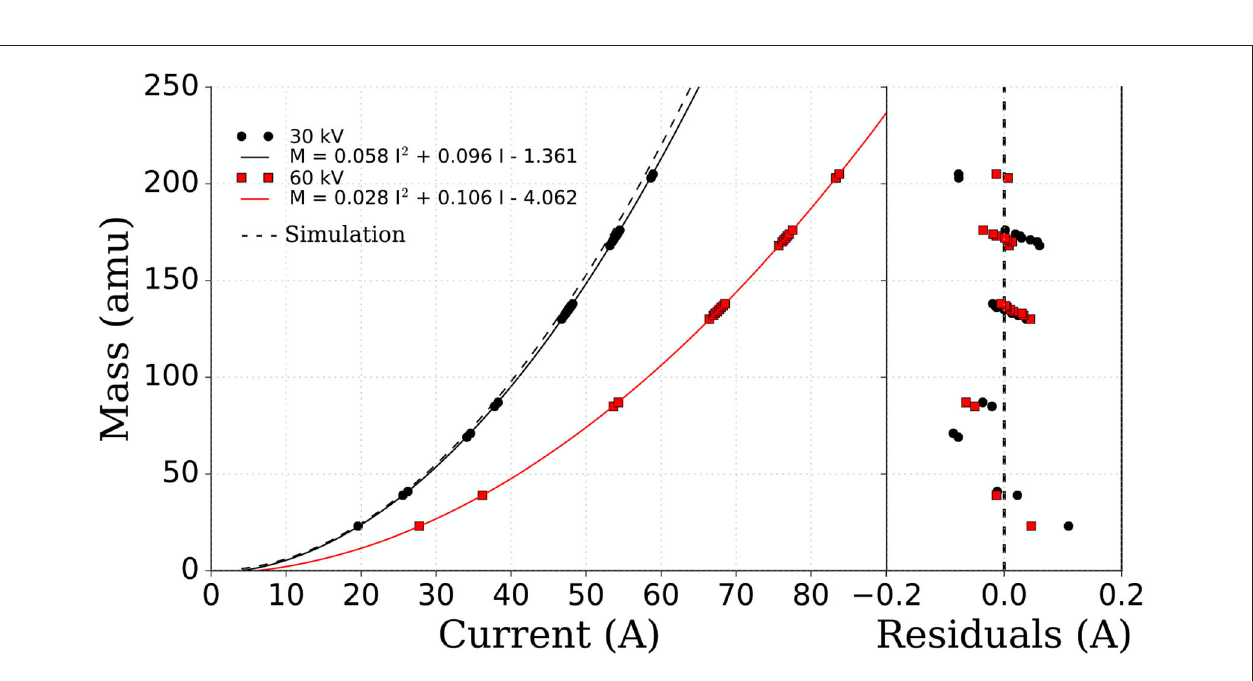
FIGURE 7 | Calibration curve of the MEDICIS dipole magnet for 30 and 60 kV extraction voltage. The solid lines are second order polynomial fits to the experimental data. The simulated curve obtained from OPERA calculations is represented by the dashed line. The fit residuals are shown in the right hand side of the